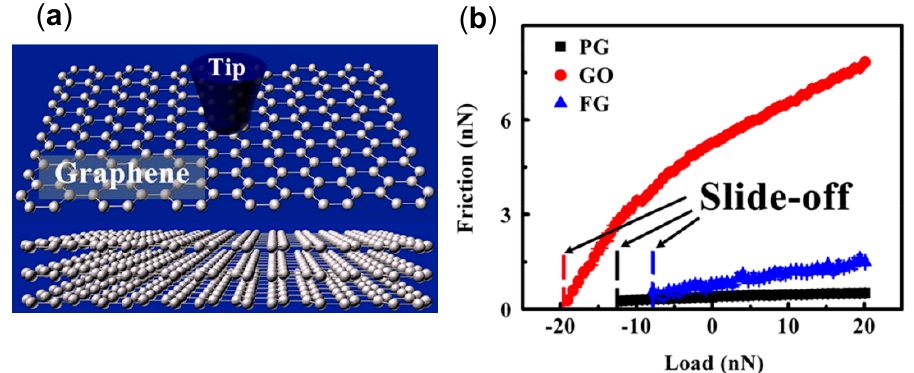
Figure 19. The friction measurements on graphene surface ( a ) and the friction forces as a function of load on pristine graphene (PG), graphene oxide (GO), and fluorinated graphene surfaces ( b ). Reprinted from Ref. [126], Copyright 2018, with permission from ACS publications.